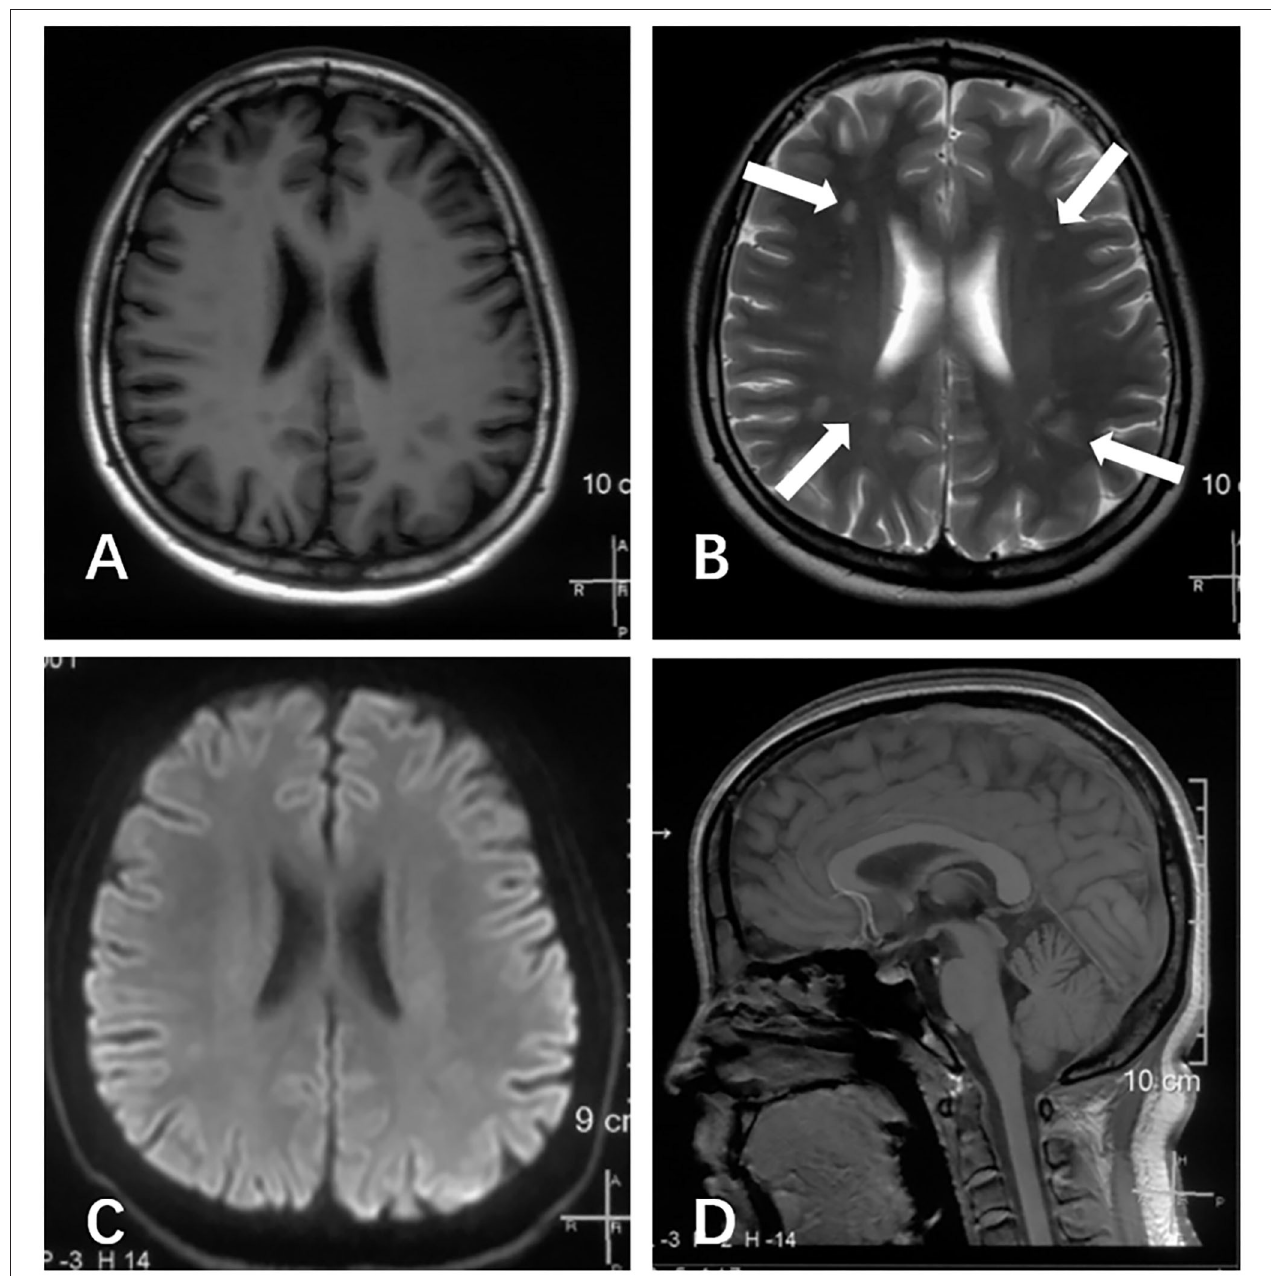
FIGURE 1 | Brain MRI scans of this patient, performed at age of 16 years during the interictal period. (A) Axial T1 image revealed several hypointense lesions of the centrum semiovale and white matter of the bilateral frontoparietal temporal lobe. (B) Axial T2 image revealed several hyperintense lesions at the same locations (arrows). (C) The axial diffusion-weighted imaging (DWI) image appeared normal. (D) Sagittal T1 image demonstrated slightly cerebellum